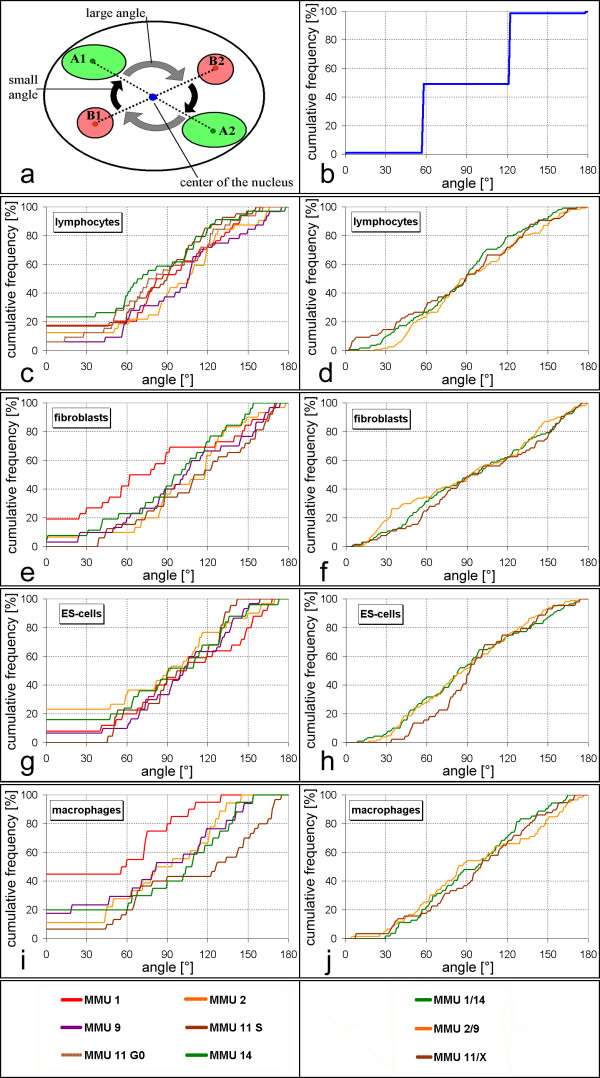
Angles between chromosome territories. (a) Scheme of fixed chromosomal angles between two pairs of chromosomes as predicted by the model of genome separation with antiparallel orientation [36]. In this example, specific angles are assumed to be about 60° and 120°. A cumulative distribution plot of homologous angles in this model has a steep increase from 0 to 100% near 180° (not shown). (b) Cumulative distribution of heterologous angles in this model example. For other chromosome pairs, angles and respective sharp increases of cumulative graphs would be at other values. Cumulative plots are shown for the indicated cell types. (c-j) Experimentally observed cumulative distributions of angles between homologous (c,e,g,i) or heterologous (d,f,h,j) chromosome territories in the indicated cell types.